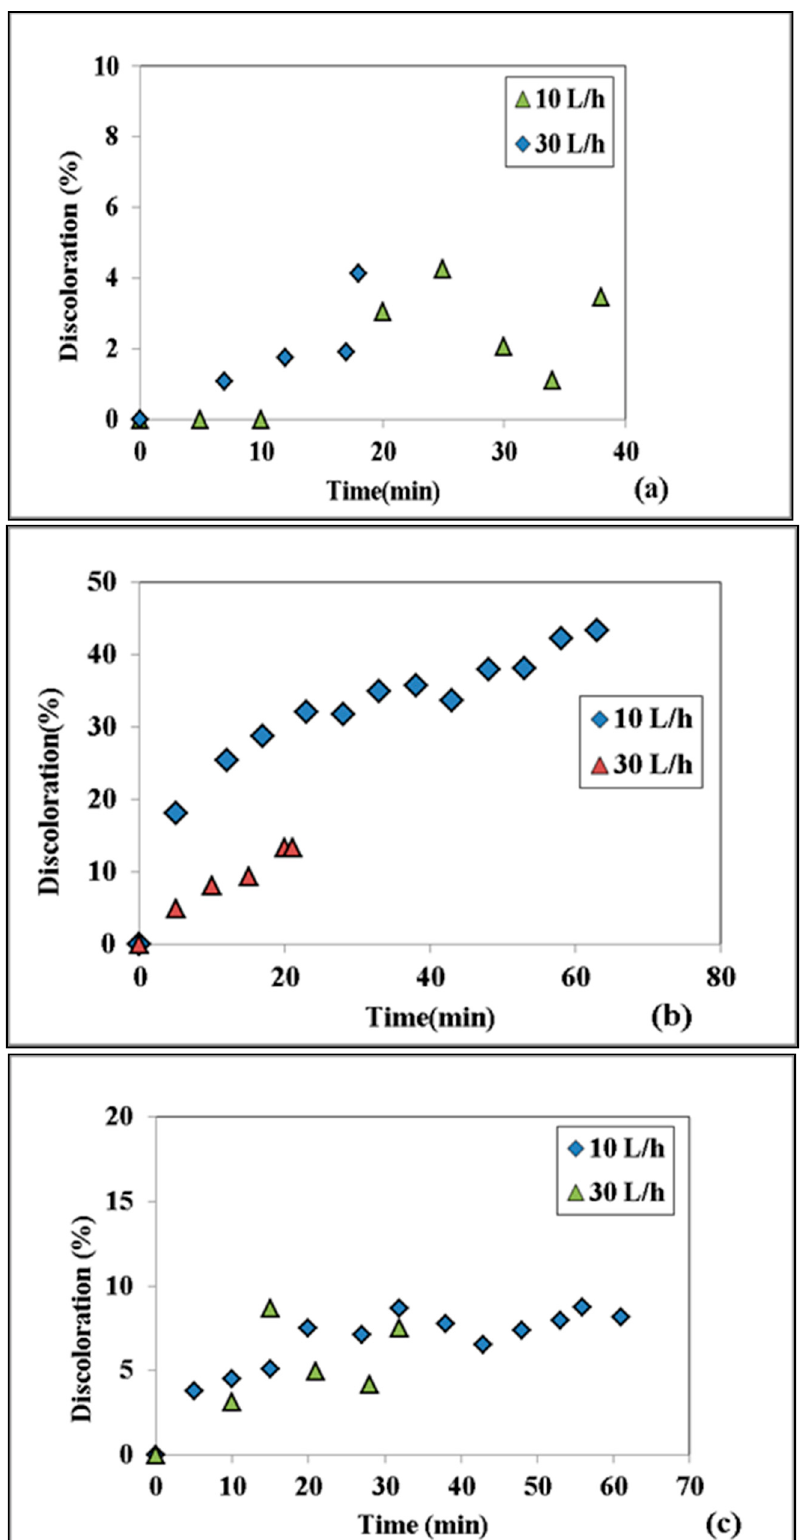
Figure 4. Color removal dependence on WW flowrate at different disc rotational speeds: ( a ) 100 rpm, ( b ) 300 rpm, ( c ) 500 rpm . The maximum WW color removal values for different flowrates and disc rotational speeds can be accessed in Supplementary Data Section (Table ST2). The color removal